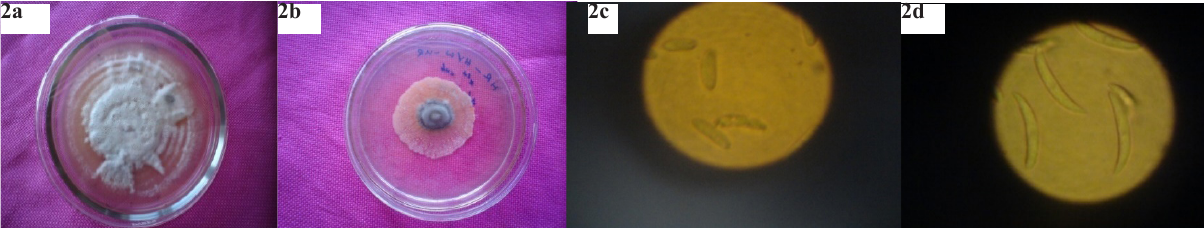
Figure 2: Pure cultures; C. gloeosporioides 2a: C. gloeosporioides and 2b: C. capsici and conidia; 2c: C. gloeosporioides and 2d: C. capsici